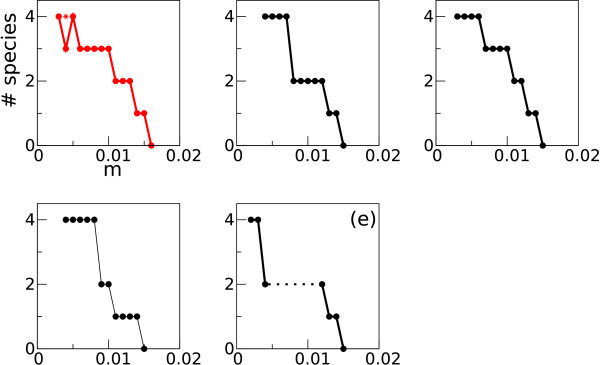
The number of evolved sequence classes (species) as a function of the mutation rate for five simulation series. For each series, simulations were initialized with a homogeneous population of different pre-evolved replicators. At some high mutation rate, the number of species drops to zero. This indicates that the system collapses because the mutation rate is above the error-threshold. Plots are not drawn for low mutation rates, because the number of species and their sequence patterns fluctuate in this region of the mutation rate. The red-colored plot is for the simulation series that are described in main text. For μ = 0.004, the system eventually evolved to the three species system (the C- and the A-catalyst, and the G-parasite) as explained in main text. The star depicted at μ = 0.004 designates the number of species at the metastable state (note that the phylogeny for μ = 0.004 in Fig. 2 is generated in this metastable state). The plot designated by (e) is for the simulation series that exhibited functional polymorphism without speciation (the details are explained in Additional file 2). In this plot, the dotted line denotes that the number of species can fluctuate between 2 and 3 (see also Additional file 2).